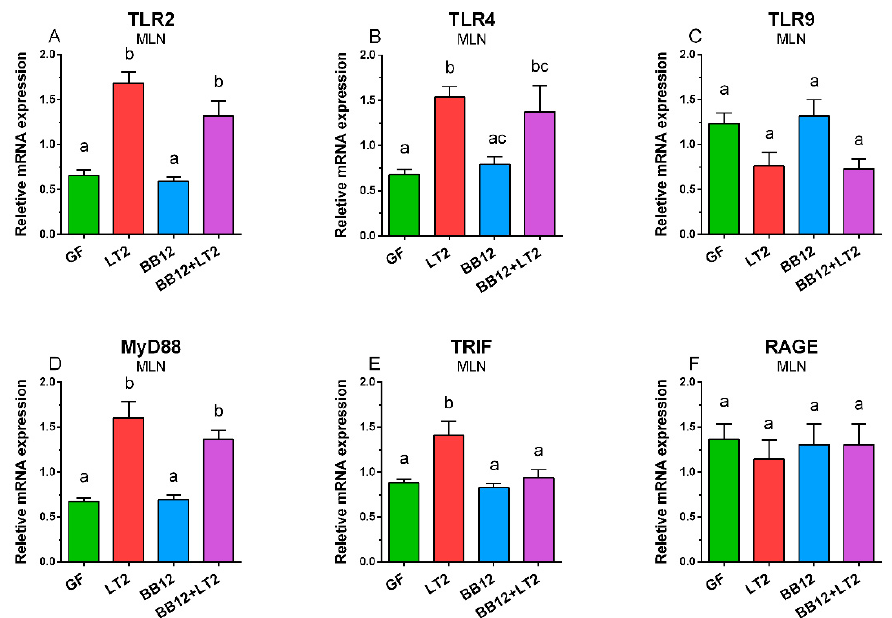
Figure 5. Relative expression (fold-change) of TLR2 ( A ), TLR4 ( B ), TLR9 ( C ), MyD88 ( D ), TRIF ( E ), and RAGE ( F ) mRNA in the mesenteric lymph nodes of the one-week-old piglets: germ-free (GF), infected with S . Typhimurium LT2 for 24 h (LT2), associated with B. animalis subsp. lactis BB-12 (BB12), and associated with BB12 and infected with LT2 for 24 h (BB12 + LT2) . Six samples from each group were analyzed, and statistical differences were calculated by a two-way ANOVA with Tukey’s multiple comparison post hoc test. The values are presented as mean + SEM, and a p < 0.05 among groups is denoted by different letters above the columns.